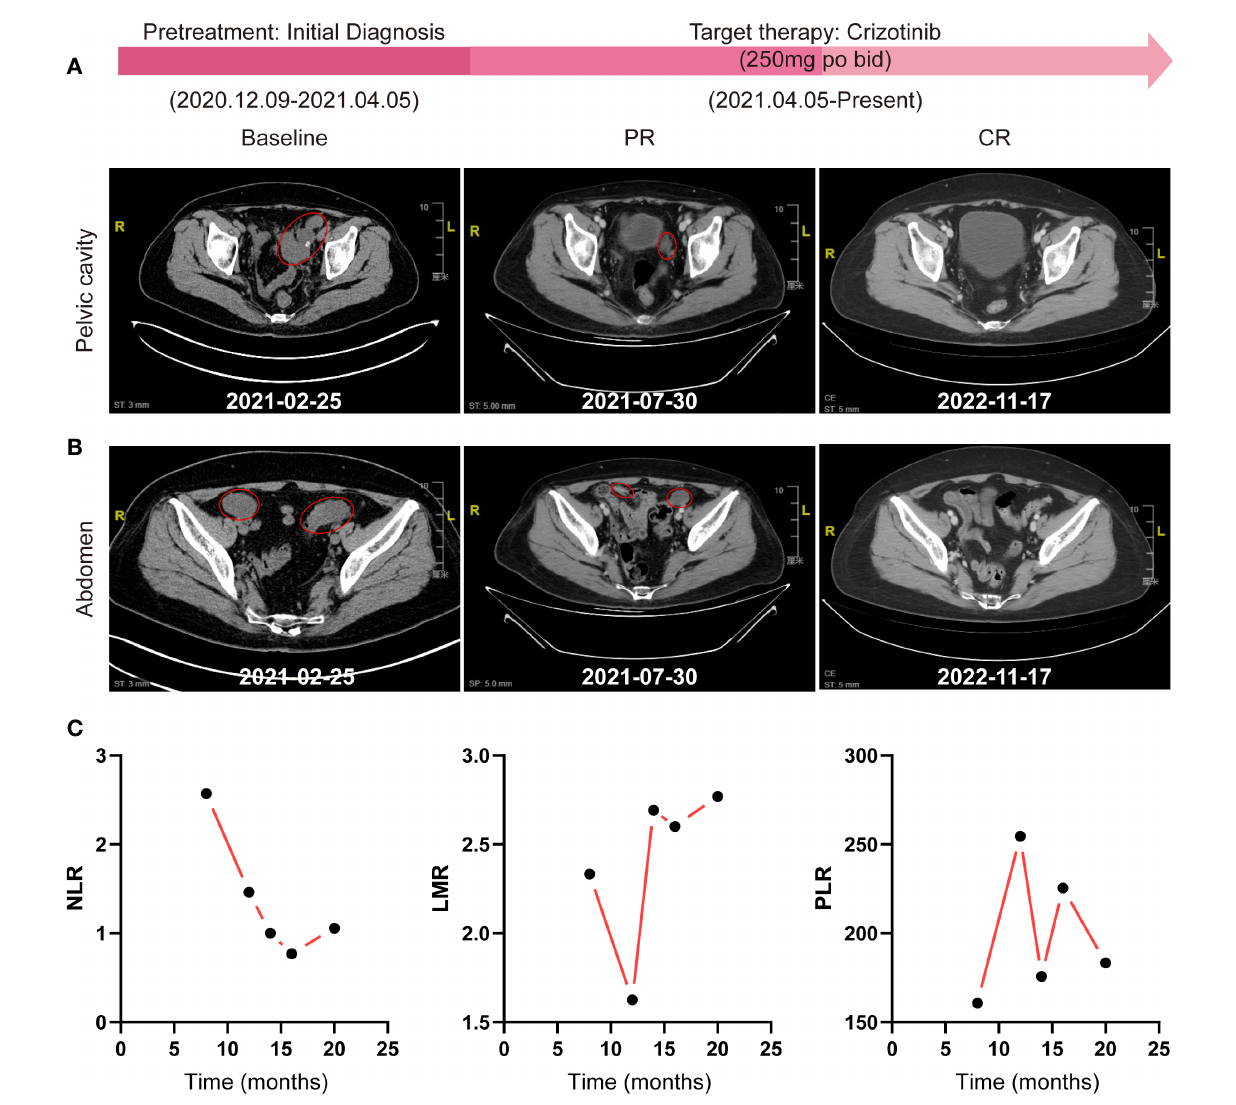
FIGURE 4 Effective evaluation by contrast-enhanced abdomen/pelvis CT scans and routine blood tests. (A, B) Radiographic assessments of target lesions by contrast-enhanced CT of the abdomen and pelvic cavity during the whole treatment process. (C) The change trends of NLR, LMR, and PLR were detected by routine blood tests. NLR, neutrophil-to-lymphocyte ratio; LMR, lymphocyte-to-monocyte ratio; PLR, platelet-to-lymphocyte